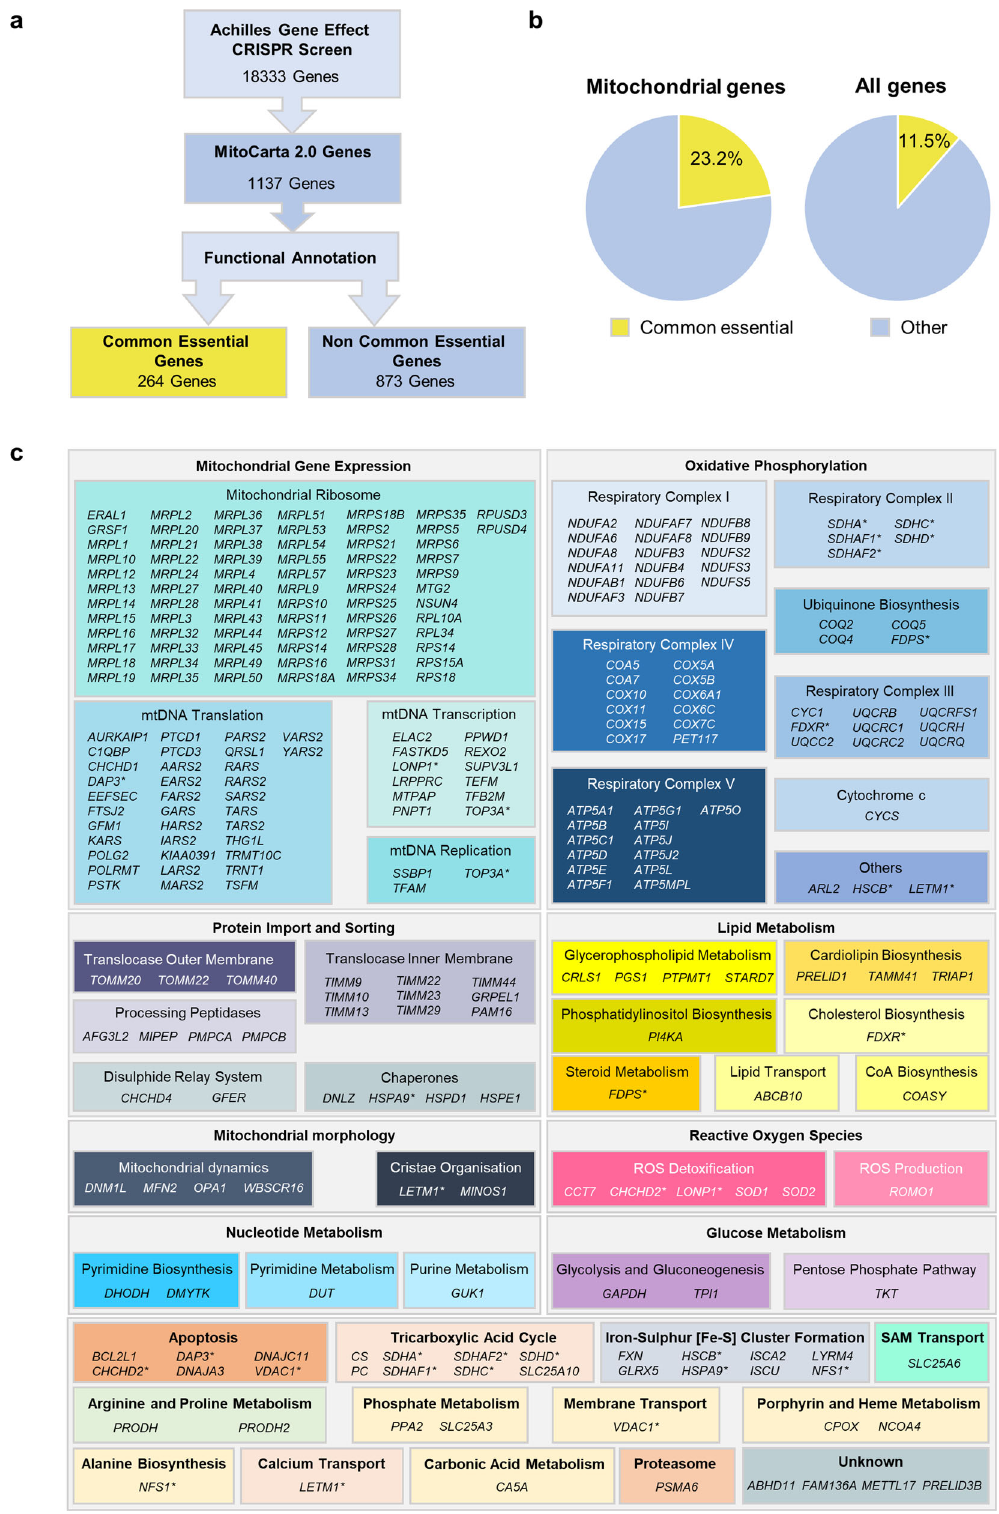
Fig. 1 The essentiality of mitochondrial genes in tumour cells. a Schematic diagram shows our analysis pathway for using the Achilles cancer dependency map (DepMap) gene essentiality data. b Pie charts show the percentage of common essential genes (shown in yellow) among mitochondrially expressed genes (left chart), and among all genes screened (right chart) in ( a ). Other (non-common essential) genes (shown in blue). c List of common essential mitochondrially expressed genes identi fi ed in ( a ), grouped by functional annotation. (*) indicates genes with multiple functions.